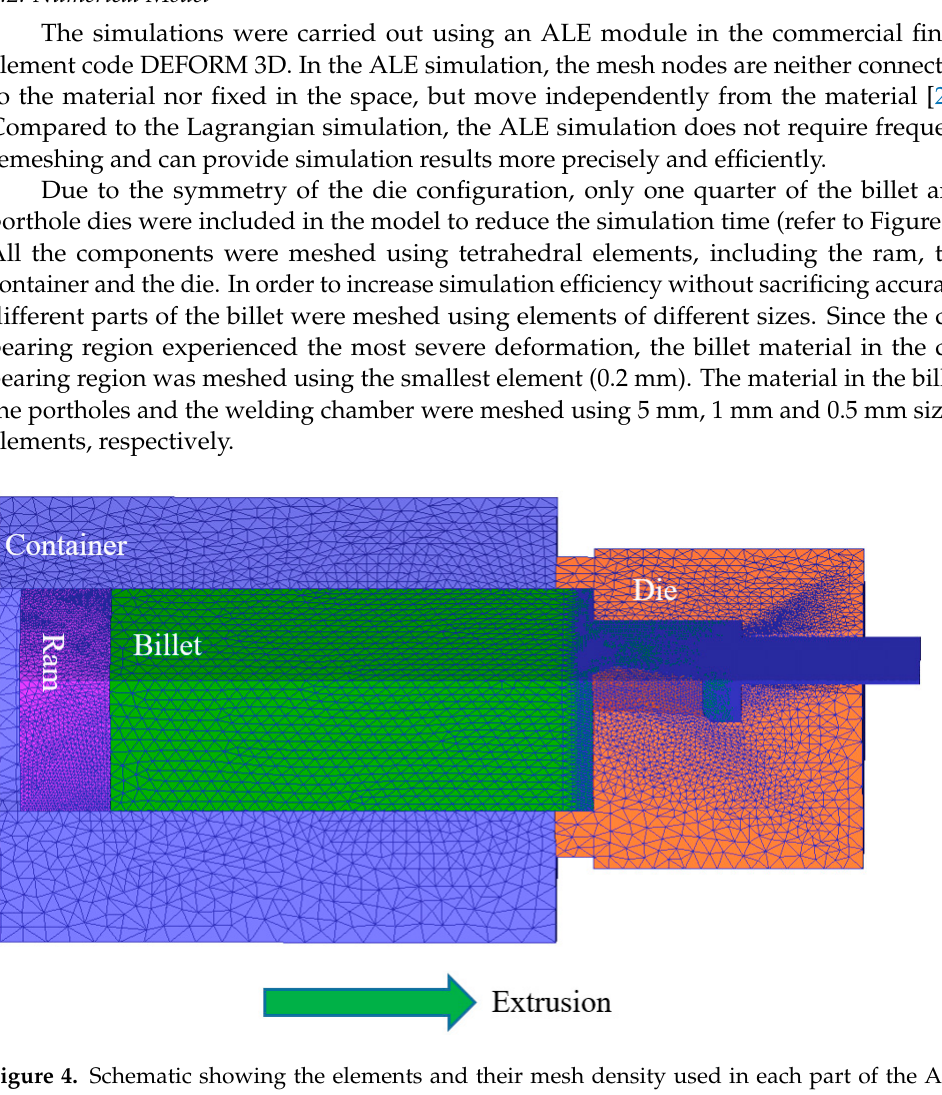
Figure 4. Schematic showing the elements and their mesh density used in each part of the ALE simulation of porthole die extrusion.